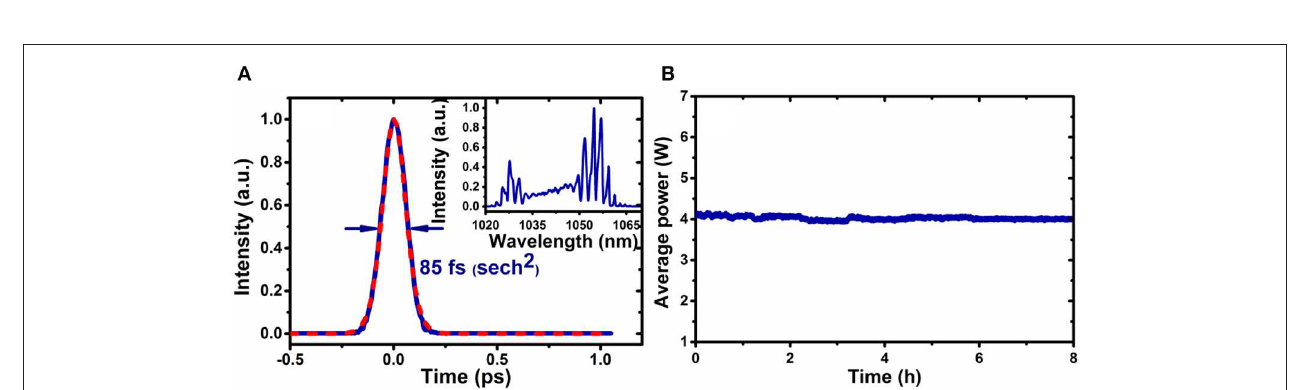
FIGURE 6 | (A) Measured compressed pulse duration and (B) power fluctuations under the maximum output power of 4W. The red dashed line and the inset in ( A ) correspond to the sech 2 fitting of the pulse and the stable mode-locking spectrum, respectively.